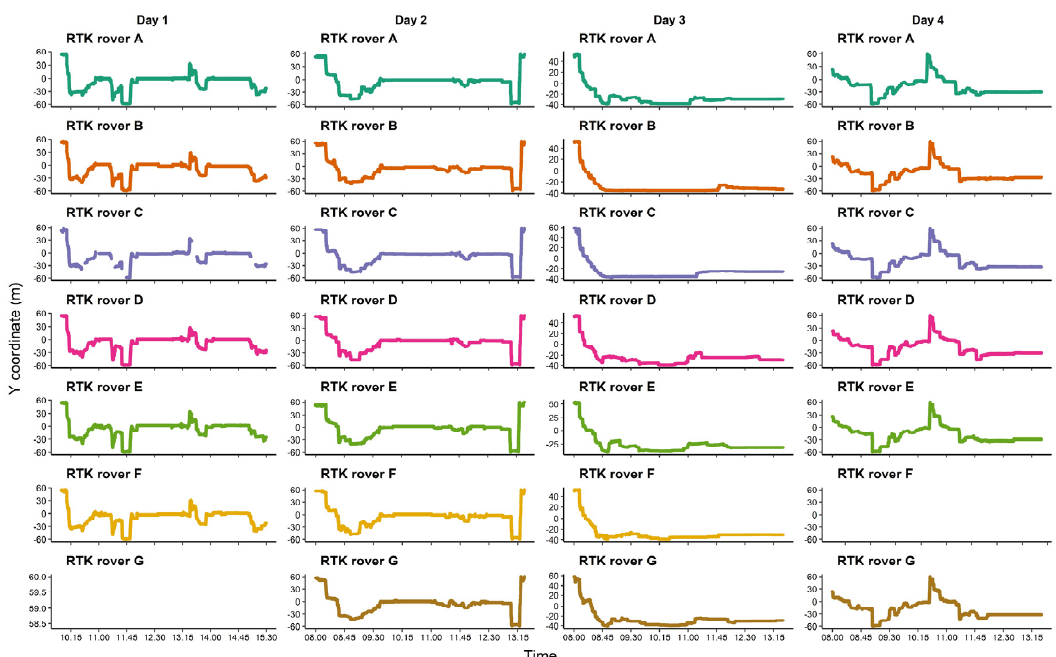
Figure 9. Consistency of recording for the RTK rovers on sheep over 5:30 h each across four study days. Due to some technical issues, RTK rover C did not record the positional data continuously on day 1 and RTK rover F did not work on day 4 (operator error). RTK rover G was not used on day 1 due to physical damage from